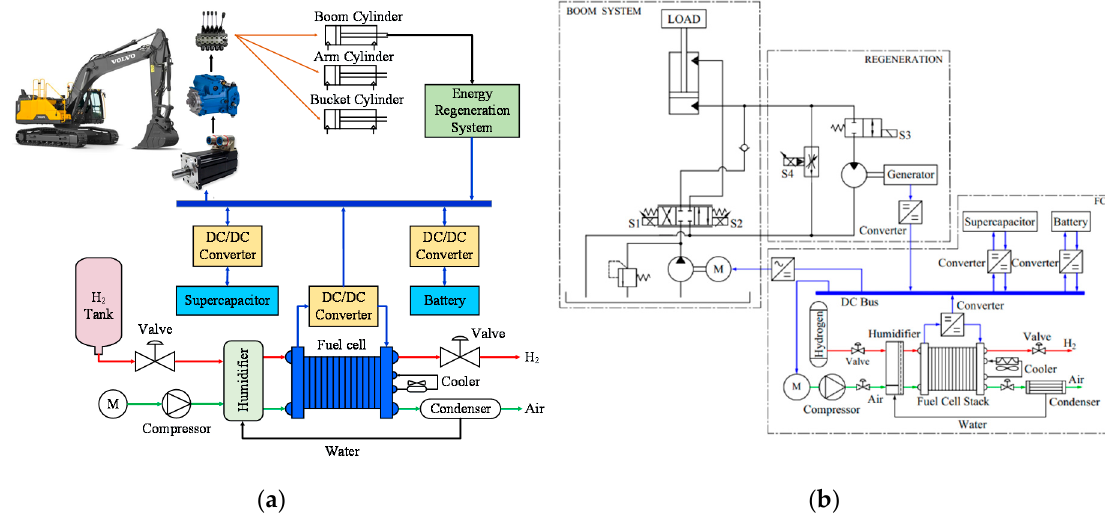
Figure 3. The structure of the new configuration: ( a ) hybrid power hydraulic excavators (HEs) and ( b ) hydraulic circuit for boom energy regeneration part.